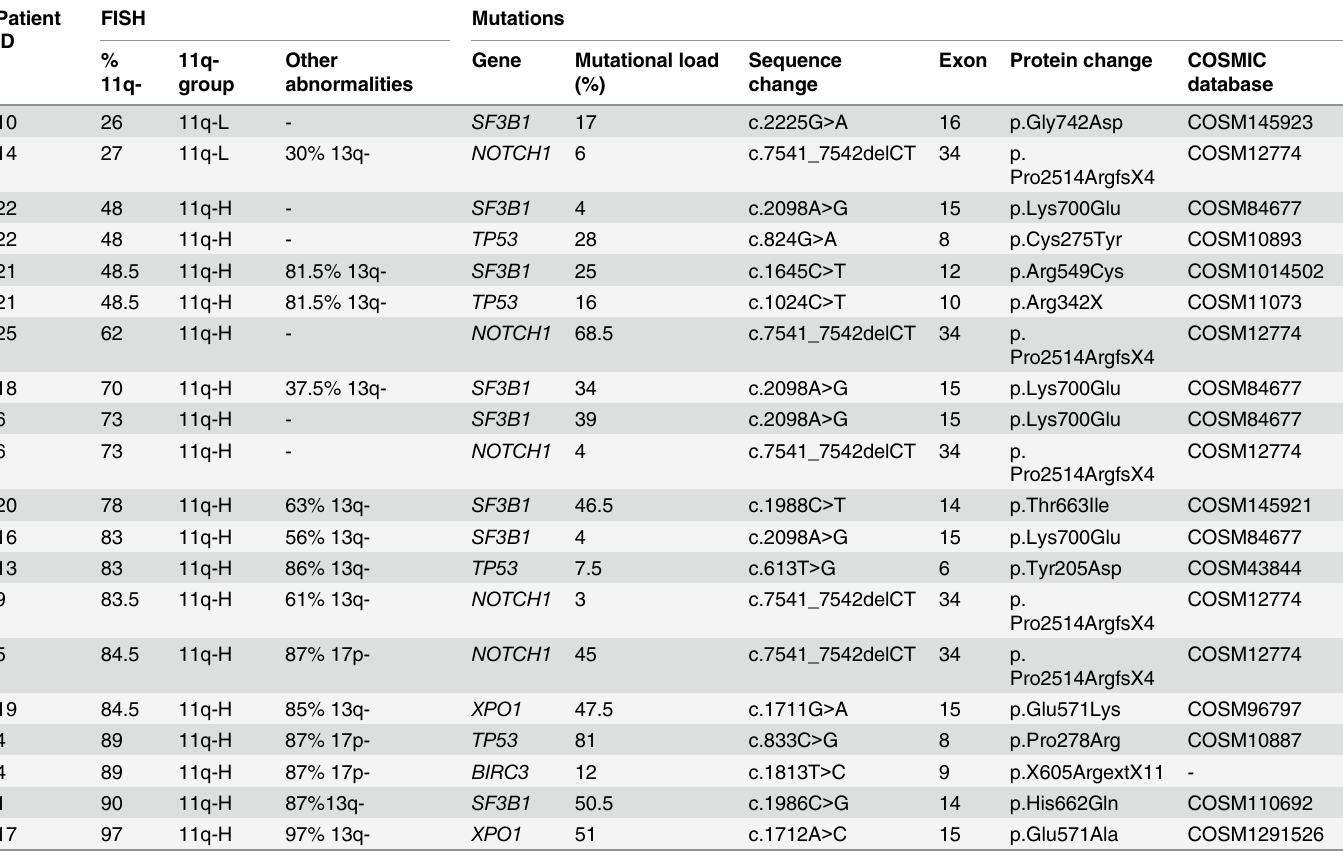
Table 5. Mutations in other genes in 25 CLL patients with